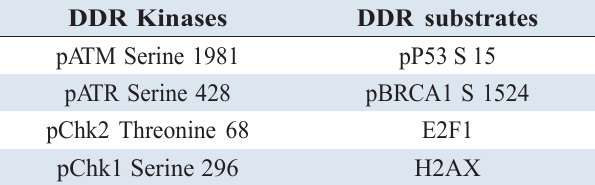
Table 2. DDR substrates analysed in the study. DDR